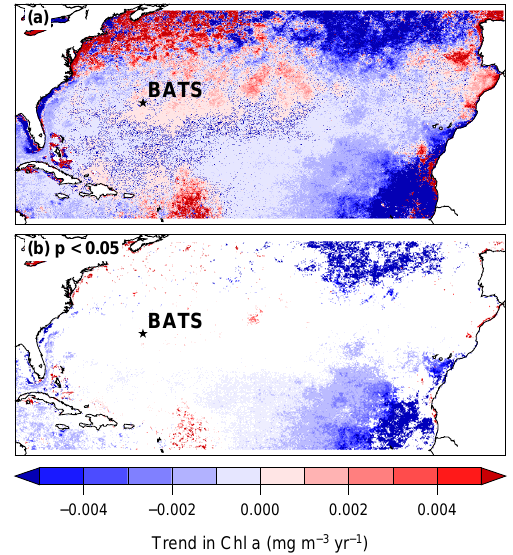
Figure 9. Trends in Chl a concentration derived from merged satel- lite records: SeaWiFS and MODIS (1998–2014). The bottom map (b) shows significant trends ( p < 0 .